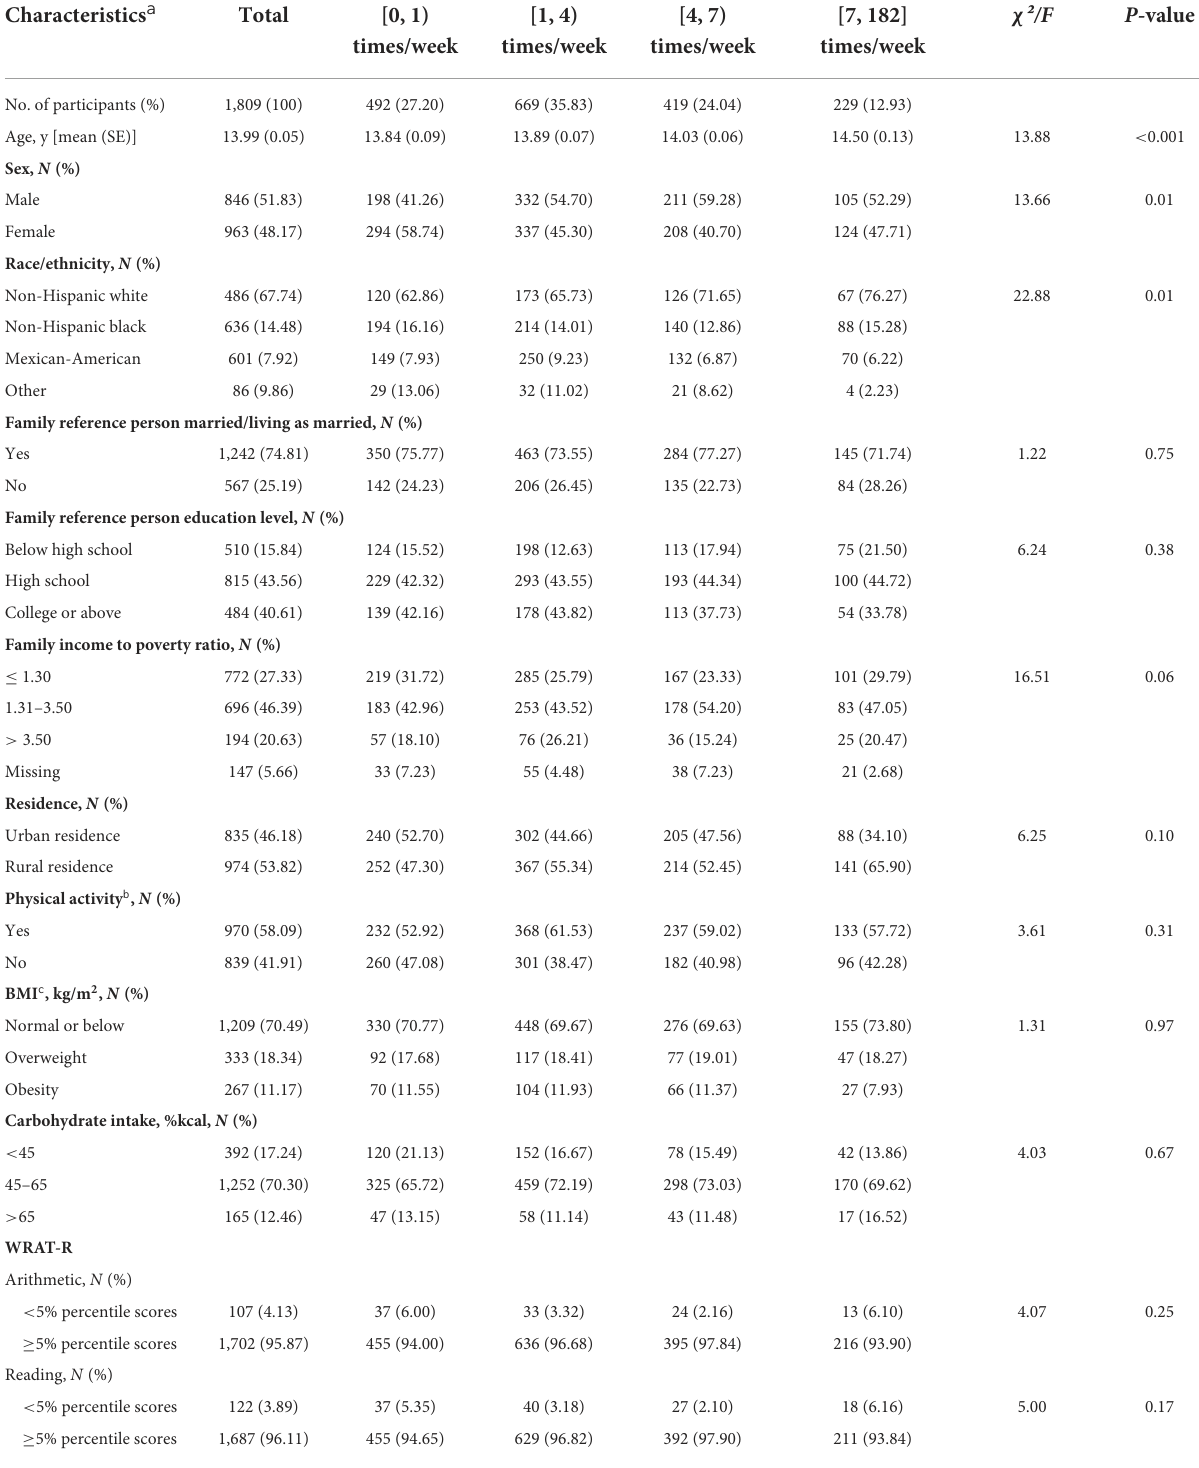
TABLE 1 Mean (continuous variables) and proportion (categorical variables) differences in cognitive function, socioeconomic status, and demographics of adolescents aged 12–16 years are presented by consumption of sugar-sweetened beverages (SSBs) in NANESIII, 1988–1994. Frequency of intake of SSBs Characteristics